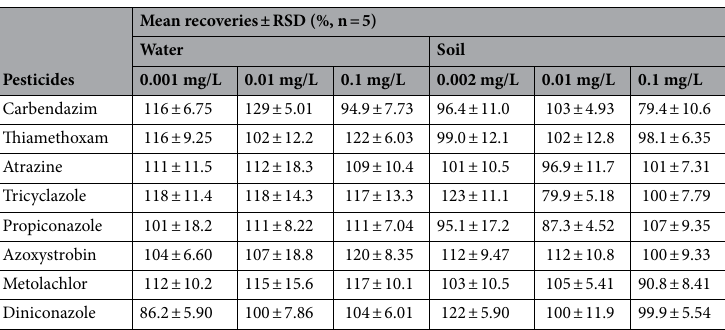
Table 3. Mean recoveries and relative standard deviation of eight pesticides in soil and waters. Mean recoveries of eight pesticides in soil and waters were in the range of 79.4–129%, and the relative standard deviation (RSD) varied from 4.52 to